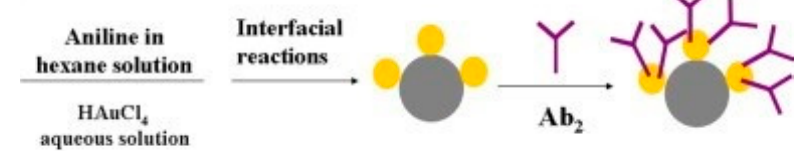
Figure 12. Schematic representation of the preparation of the PANi–Au AMNPs-Ab2. Reproduced with permission from [55].